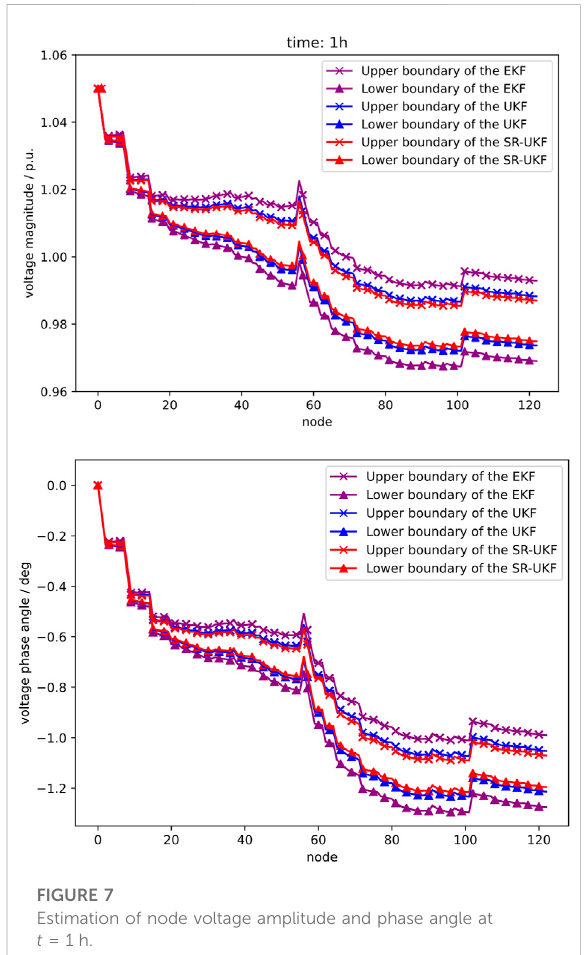
Estimation of node voltage amplitude and phase angle at t = 13 h.